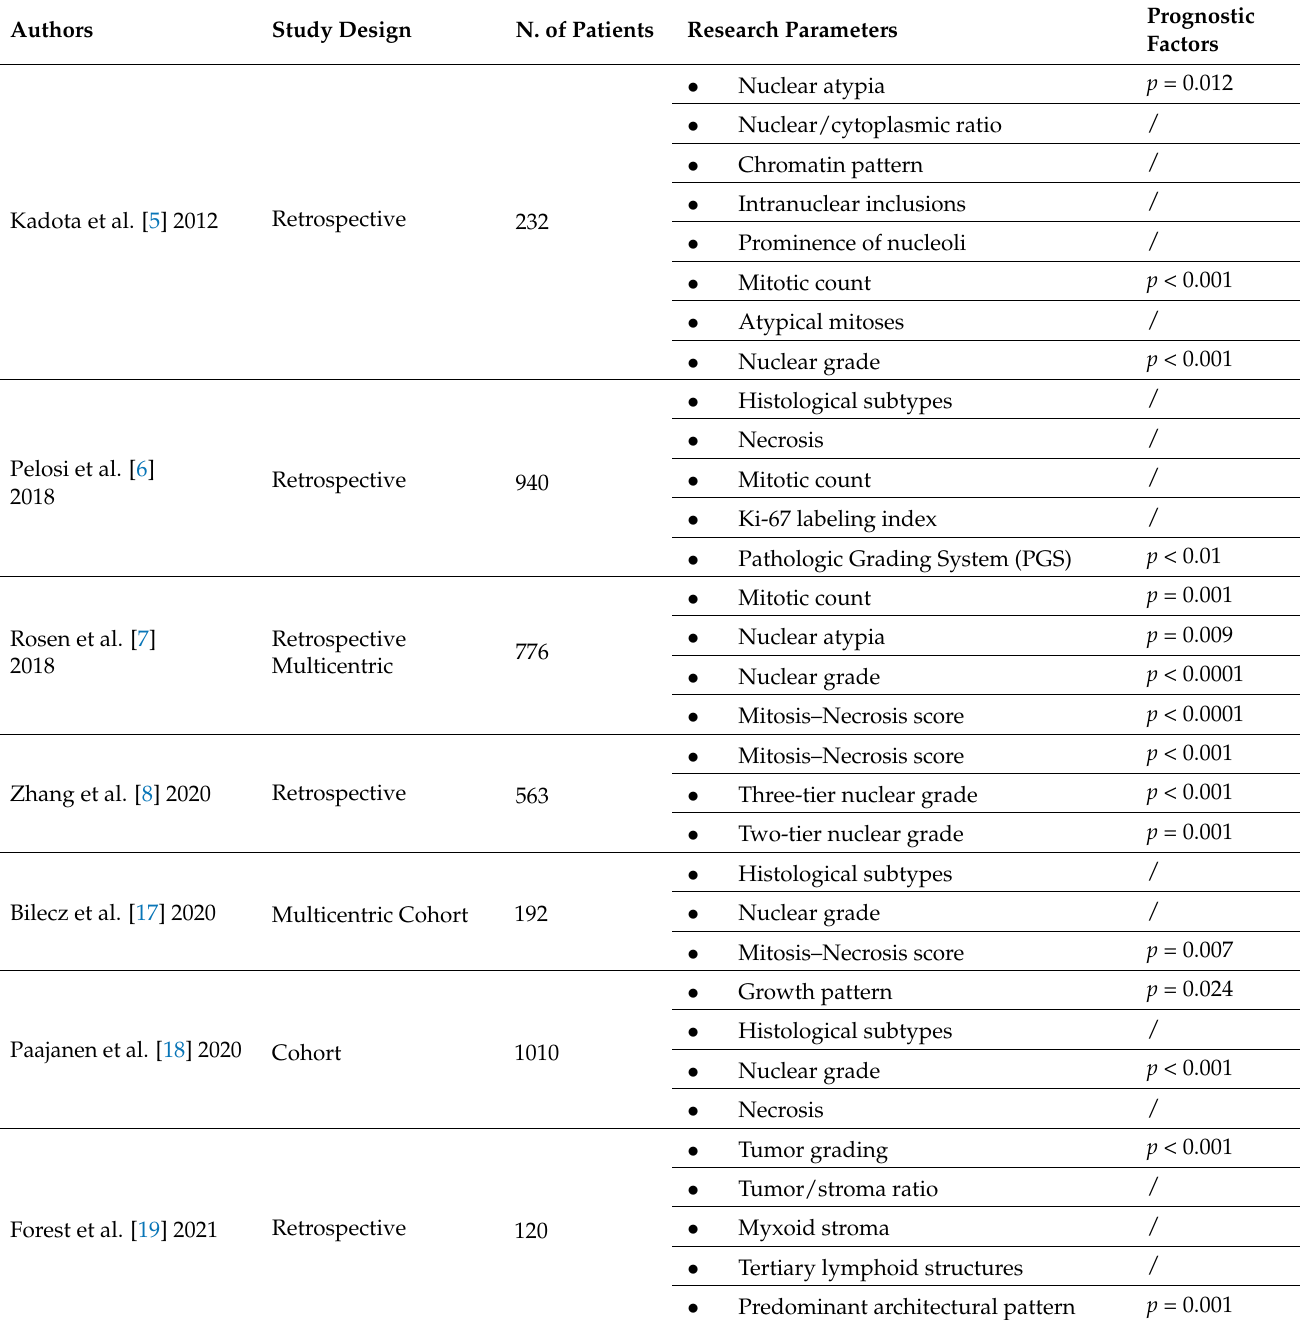
Table 2. Histological prognostic factors for pleural diffuse epithelioid